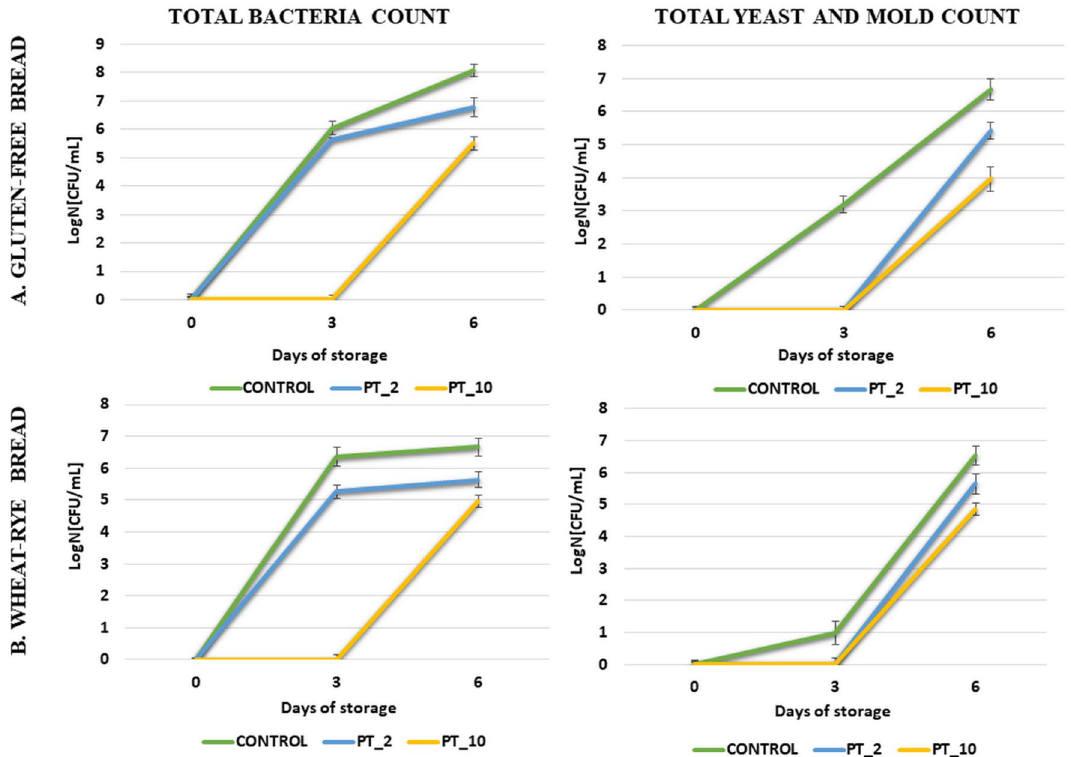
Figure 4. Effect of CAP treatment for 0, 2, and 10 min and storage at 20 °C for 0–6 days on the total mesophilic bacterial count and total yeast and mold growth in gluten-free bread and wheat-rye bread. Vertical bars depict